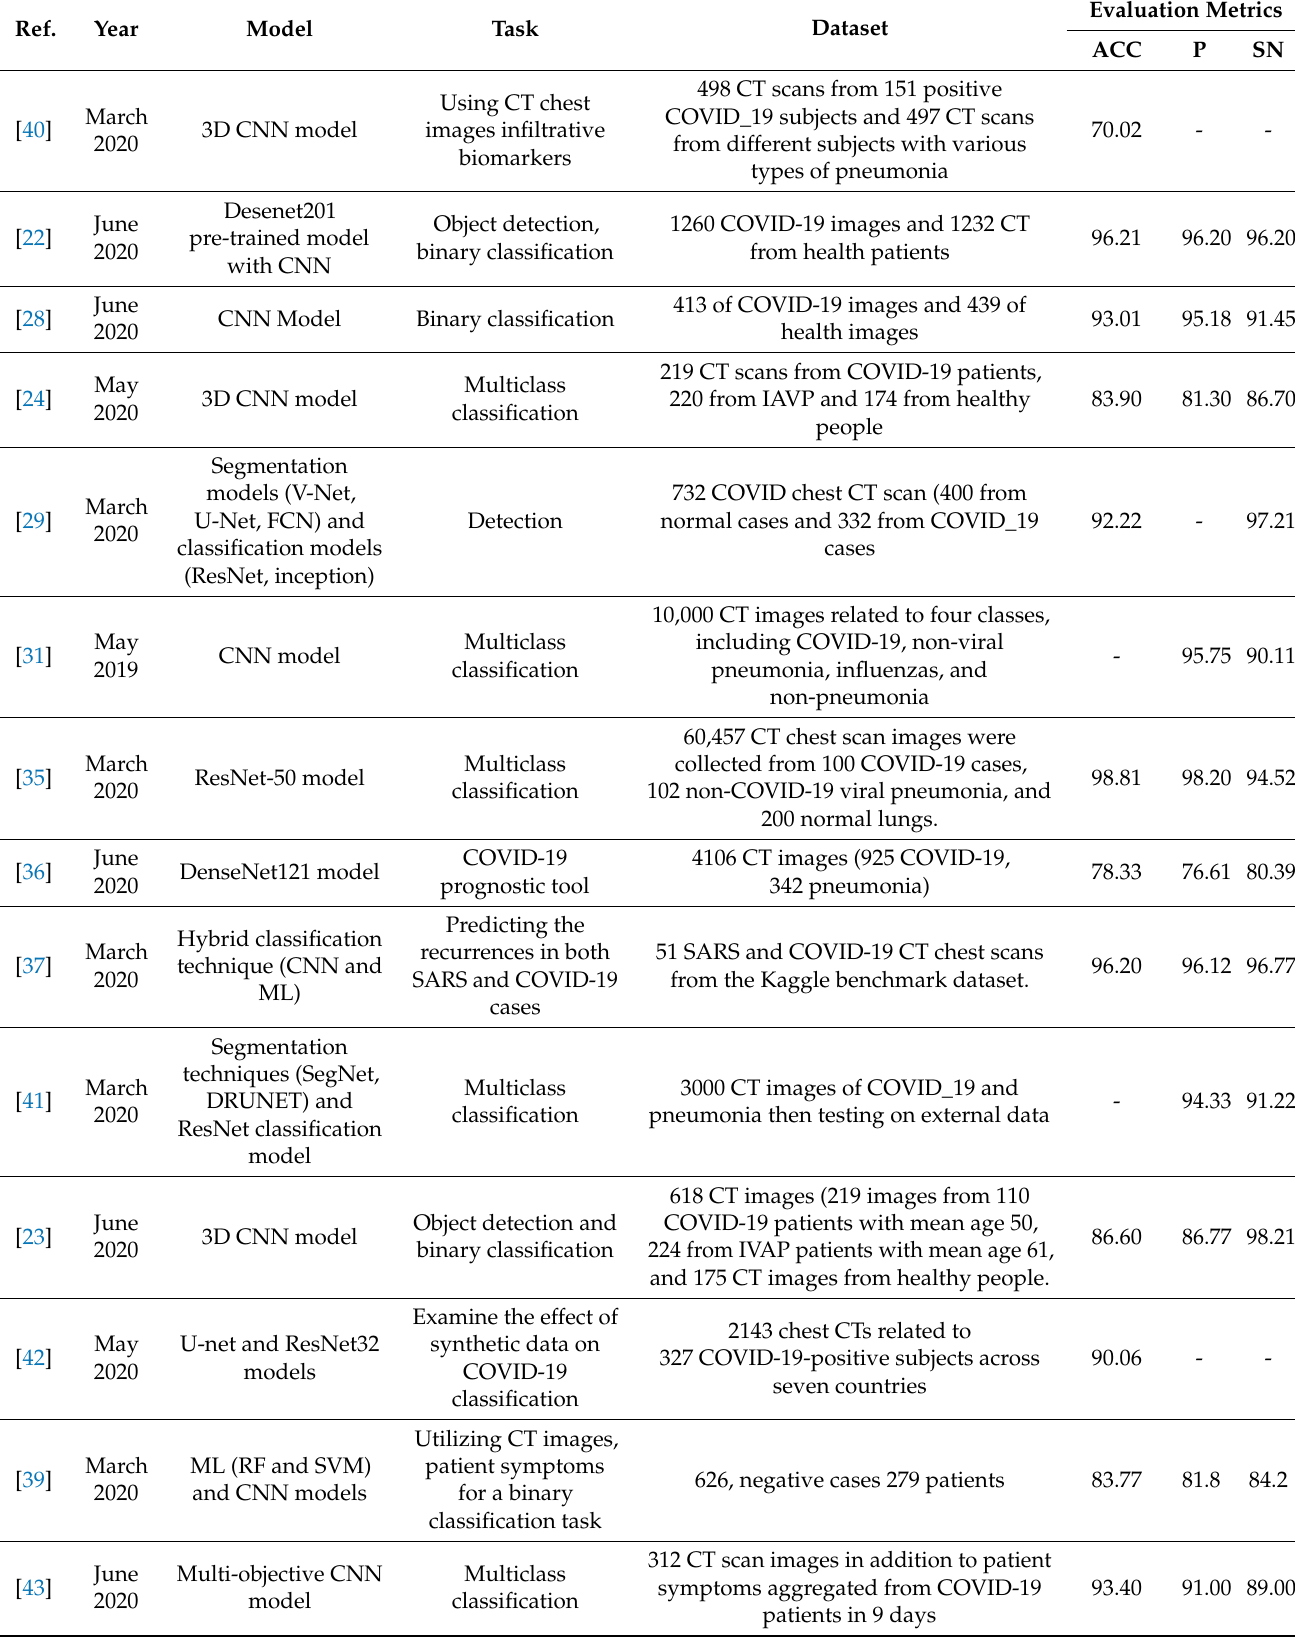
Table 2. Diagnosis ML and DL algorithms based on CT scans for COVID-19 patients.